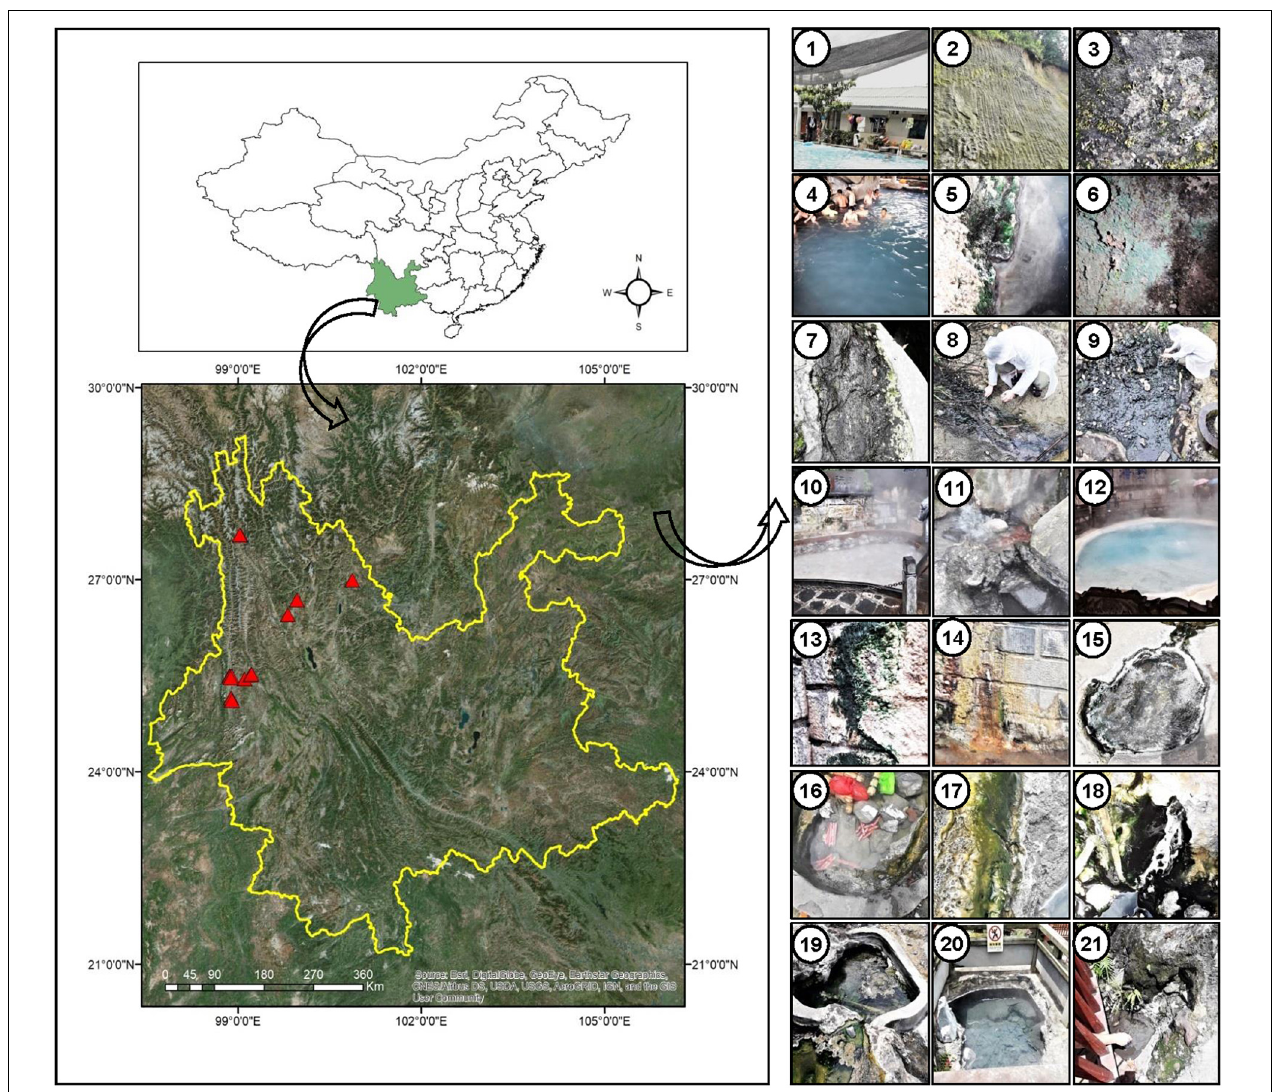
FIGURE 1 | Location of sampling sites (marked with red triangles) in Yunnan Province, China. Geographic coordinates were determined using a Garmin Etrex GPS. Digital Elevation Model (DEM) data information was downloaded from Resource and Environment data cloud Platform of China (http://www.resdc.cn/). Pictures in the right panel indicate the surrounding sampling environment of the cyanobacterial biofilms in different hot springs, 1: Dongshan-001, 2–3: Huangpo-002 (soil), 4–7: Huangpo-003 (4 samples), 8: Rehai (Hamazui)-004, 9: Rehai (Hamazui)-005, 10: Rehai (Yanjingquan)-006, 11: Rehai (Zhenzhuquan)-007, 12: Rehai (Dagunguo)-008. 13–14: Rehai (Dagunguo)-009, 15: Banglazhang-011, 16–17: Banglazhang-012, 18: Banglazhang-013, 19: Banglazhang-014, 20: Banglazhang-015, 21: